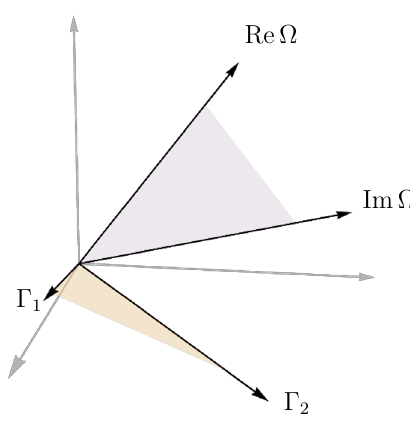
Figure 3 . A sketch of the (four dimensional) space H 3 ( X; R ) for generic ’ , showing the two planes generated by Re (cid:10) and Im (cid:10) and by charge vectors (cid:0) 1 and (cid:0) 2 . As ’ varies, the plane generated